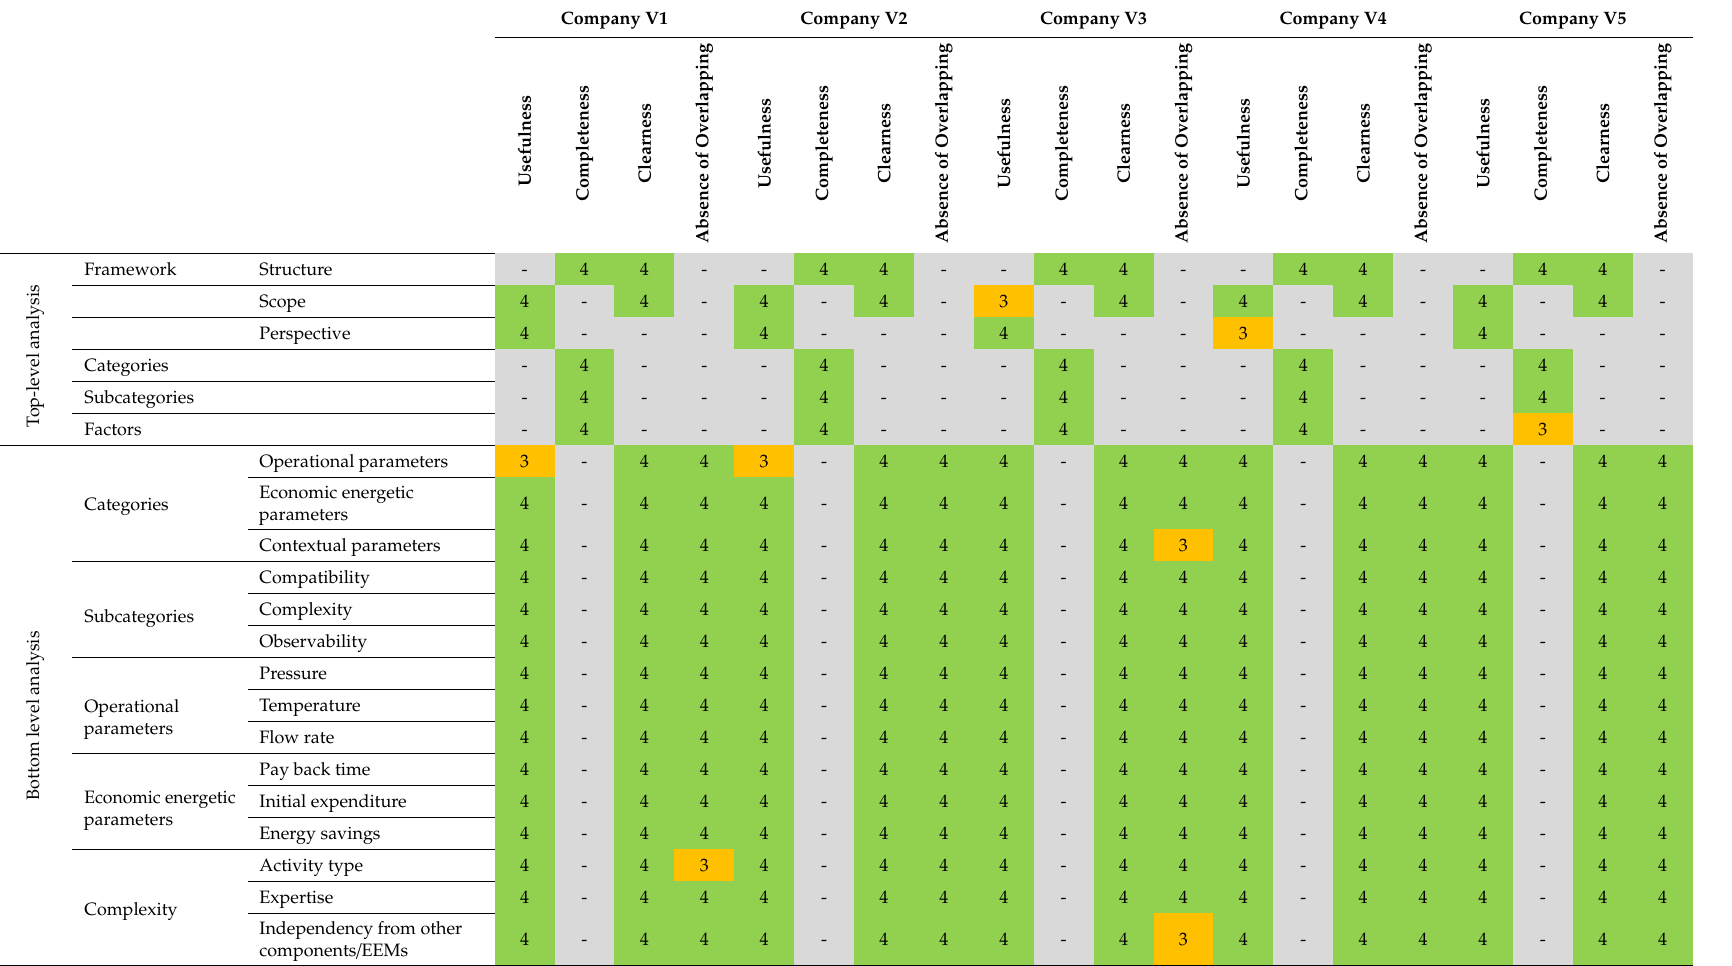
Table A1. Scores for the theoretical validation of the framework a